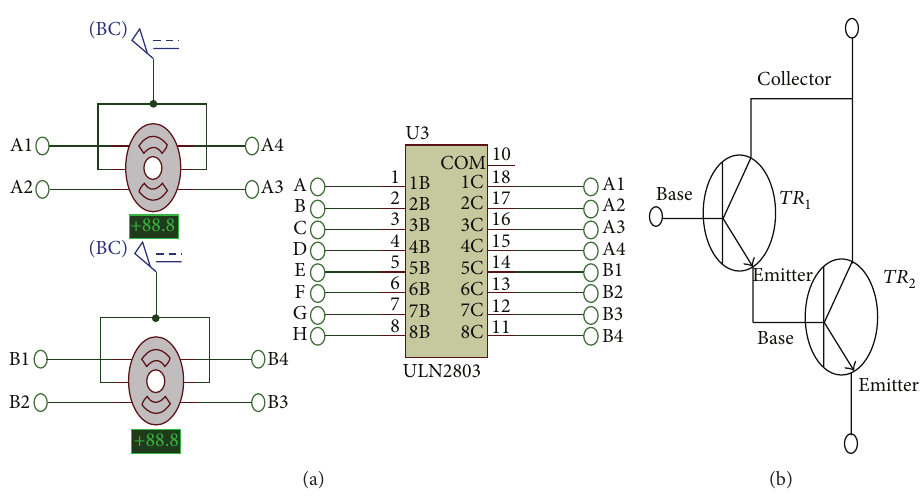
Figure 12: Movement adjustment unit: (a) the unipolar stepper motor and motor driver device (ULN2803) and (b) Darlington pair.